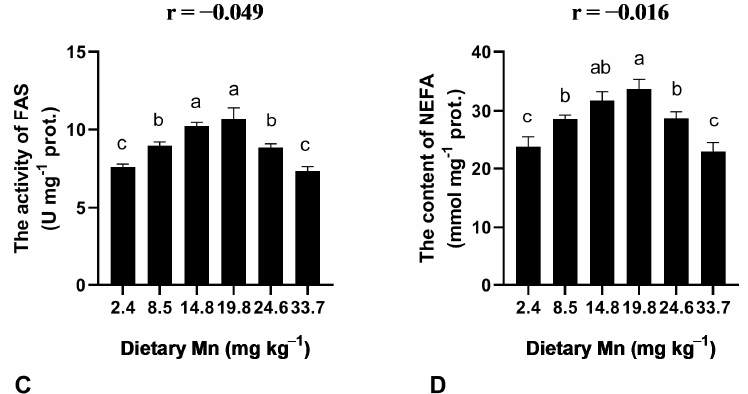
Figure 3. Effect of dietary Mn on the activities of lipid metabolism enzymes and NEFA content in the liver of post-larval coho salmon. ( A ) LPL activity; ( B ) HL activity; ( C ) FAS activity; ( D ) NEFA content. Data were expressed by mean ± SE ( n = 3). One-way ANOVA followed by Tukey HSD was used to determine whether Mn levels significantly ( p < 0.05) affected the observed responses. The different superscript letters are significantly different ( p < 0.05). In addition, a two-tailed Pearson Correlation test was used to determine the correlation between dietary Mn levels and the values of lipid metabolism. Abbreviations: lipoprotein lipase (LPL), hepatic lipase (HL), fatty acid synthetase (FAS), nonesterified fatty acid (NEFA).